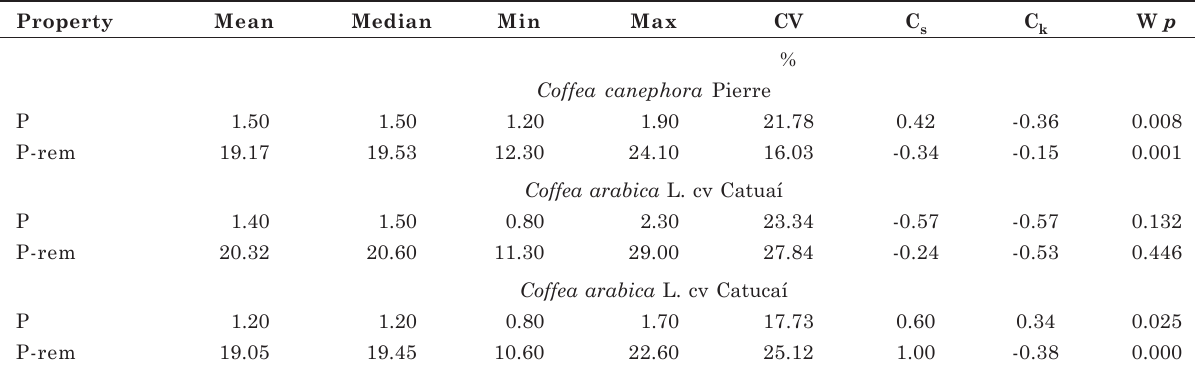
Table 2. Descriptive statistics of data of foliar phosphorus and remaining phosphorus in the